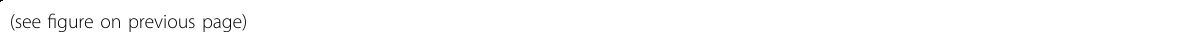
Fig. 5 Spontaneous and evoked calcium activity analysis of 2D cortical cultures at day 70. A Calcium traces as a function of Δ F/F 0 of FAST (top) and SLOW (bottom) active cells. B Representative calcium trace (insert from panel A ) showing extracted functional properties: rising time (a), amplitude (b), and event frequency (c). C FAST active cells with respect to total cells in both FMRP-KO and FMRP-WT populations ( n = 14 FOVs for genotype; 144 ± 13 total cells in WT, 28 ± 6 active cells in WT; 168 ± 8 total cells in KO, 34 ± 5 active cells in KO; rising time 1.3 ± 0.1 sec in WT and 1.3 ± 0.03 sec in KO; differentiation batches = 1). D SLOW active cells with respect to total cells in both FMRP-KO and FMRP-WT populations ( n = 14 FOVs for genotype; 144 ± 13 total cells in WT, 56 ± 11 active cells in WT; 168 ± 8 total cells in KO, 113 ± 9 active cells in KO; rising time 5.2 ± 0.6 sec in WT and 5.1 ± 0.17 sec in KO; differentiation batches = 1). E Graph plots reporting the functional properties of FAST active cells: amplitude (left, n = 14 FOVs, * p < 0.05 KO vs WT, MW test), frequency and relative cumulative distribution (middle, n = 14 FOVs, 0.035 Hz in WT and 0.06 Hz in KO, * p < 0.05 KO vs WT) and synchronicity (right) of spontaneous calcium events of FMRP-WT and FMRP-KO fast cells ( n = 14, 0.43 ± 0.09 in WT and 0.41 ± 0.06 in KO not signi fi cant). F Graph plots reporting the functional properties of SLOW active cells amplitude (left, n = 14 FOVs, * p < 0.05 KO vs WT, MW test), frequency and relative cumulative distribution (middle, n = 14 FOVs, 0.025Hz in WT and 0.025 Hz in KO, not signi fi cant) and synchronicity (right) of spontaneous calcium events of FMRP-WT and FMRP-KO slow cells ( n = 14, 0.51 ± 0.05 in WT and 0.6 ± 0.03 in KO, not signi fi cant). G Representative FOV showing a puffer pipette for local Glutamate and GABA application with a cartoon showing the experimental approach. H Glutamatergic calcium transient response of FMRP-KO and FMRP-WT cortical neurons after puffer applications ( n = 5 FOVs, 23 ± 4.7 total cells and 17 ± 4 active cells in WT; n = 4 FOVs, 22 ± 2 total cells and 18 ± 1 active cells in KO; ** p < 0.01 KO vs WT; differentiation batches = 1). I GABAergic calcium transient response of FMRP-KO and FMRP-WT cortical neurons after puffer applications ( n = 5 FOVs, 22.6 ± 3.5 total cells and 7 ± 1.8 active cells in WT; n = 5 FOVs, 14.6 ± 1.7 total cells and 11.4 ± 2 active cells in KO, ** p < 0.01 KO vs WT; differentiation batches =